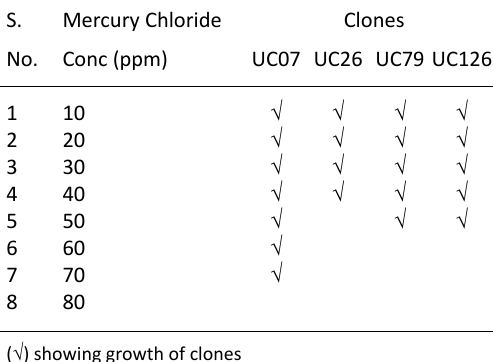
( √ ) showing growth of clones